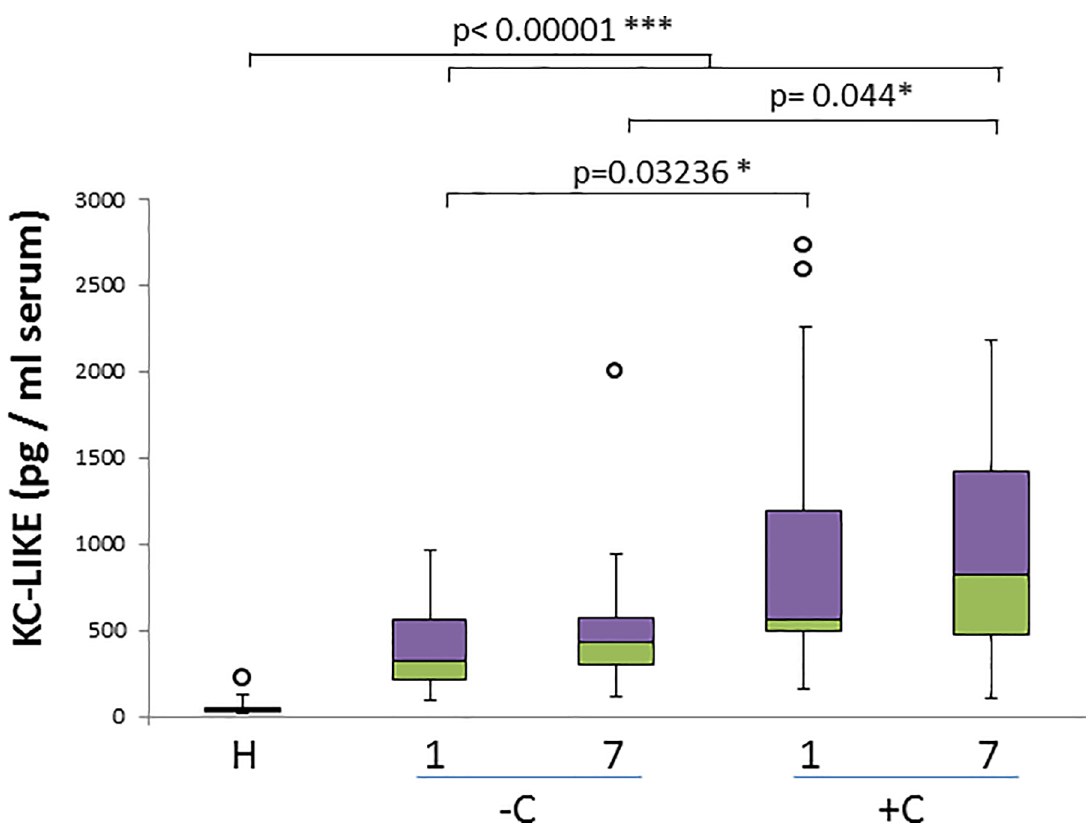
Fig 3. KC-like concentration in healthy and naturally infected dogs and its relation with outcome. Box and whisker plot with outliers showinginterquartile range (medianbar in intersect betweentwo colors in box) of KC-like concentration values amongdifferent groups: healthy dogs (H), uncomplicated (-C) and complicated(+C) cases for both day 1 and day 7. Mann- whitney test p- values are shown for comparisonof different